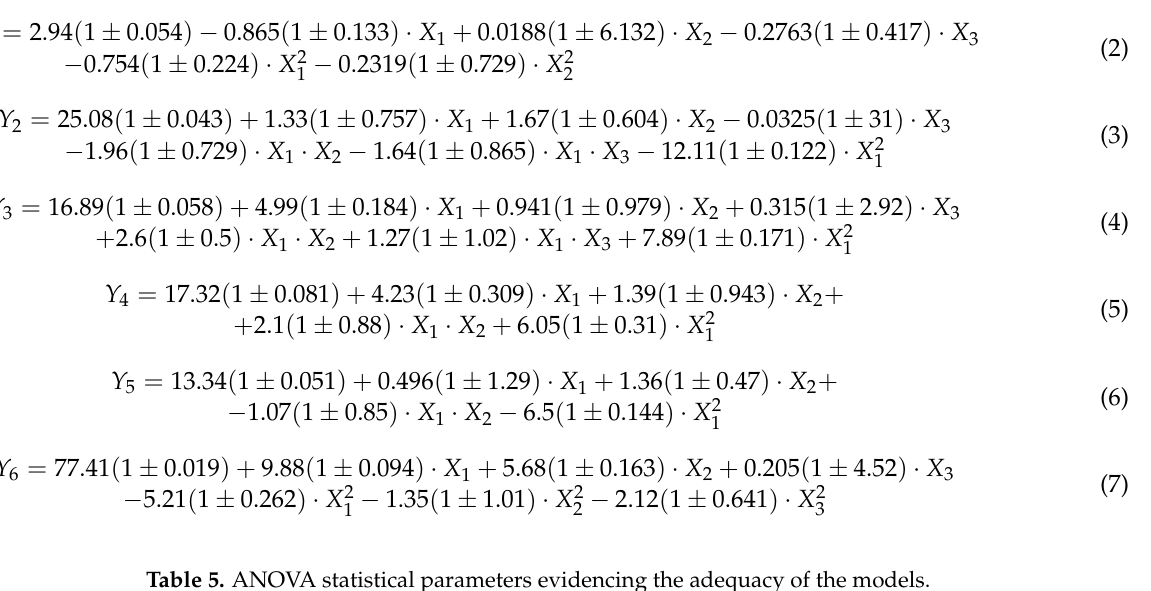
Table 5. ANOVA statistical parameters evidencing the adequacy of the